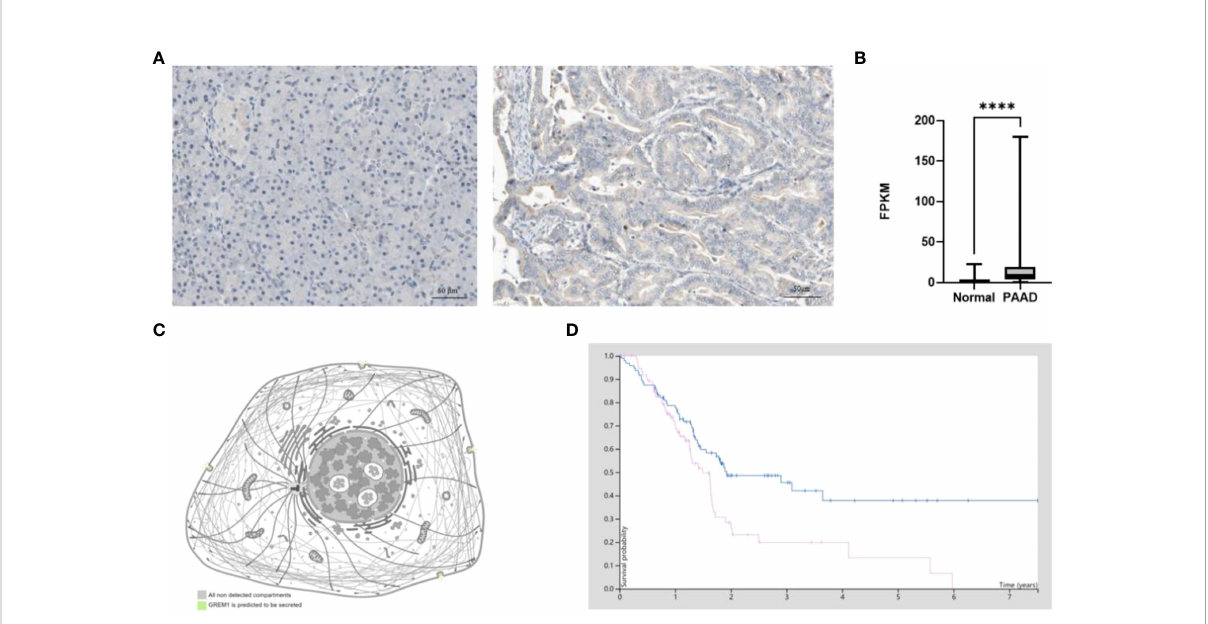
FIGURE 4 Protein level difference of GREM1 in PDAC based on HPA database. (A) Immunohistochemical staining of GREM1 in normal pancreas tissues and PDAC. (B) The difference in GREM1 mRNA transcription between normal pancreas tissues of 248 patient samples and PDAC of 176 patient samples from TCGA database. (C) GREM1 is secreted into the exocellular matrix. (D) Survival probability of PDAC patients with GREM1 overexpression ( p = 0.011). PDAC, pancreatic ductal adenocarcinoma; HPA, Human Protein Atlas; TCGA, The Cancer Genome Atlas. **** means p-value <